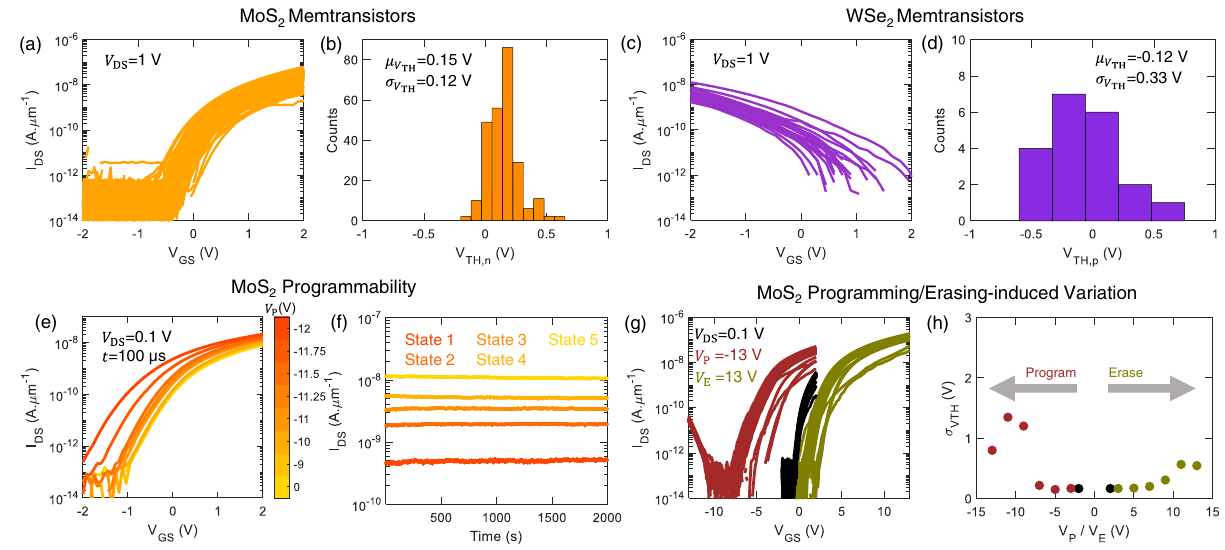
Fig. 2 | Programmable memtransistors. a Device-to-device variation in the transfer characteristics, i.e., drain current ( I DS ) versus gate-to-source voltage ( V GS ) for drain-to-source voltage ( V DS ) of 1 V for 250 MoS 2 memtransistors, demon- strating unipolar n -type transport. Distribution of b threshold voltage ( V TH, n ) extracted from 250 MoS 2 memtransistors. c Device-to-device variation in the transfer characteristics for 20 V-doped WSe 2 memtransistors, demonstrating uni- polar p -type transport. Distribution of d threshold voltage ( V TH, p ) extracted from 20WSe 2 memtransistors.Thecorrespondingmeans( μ )andstandarddeviations( σ ) are denoted in the inset. Memtransistors offers analog and non-volatile memory,